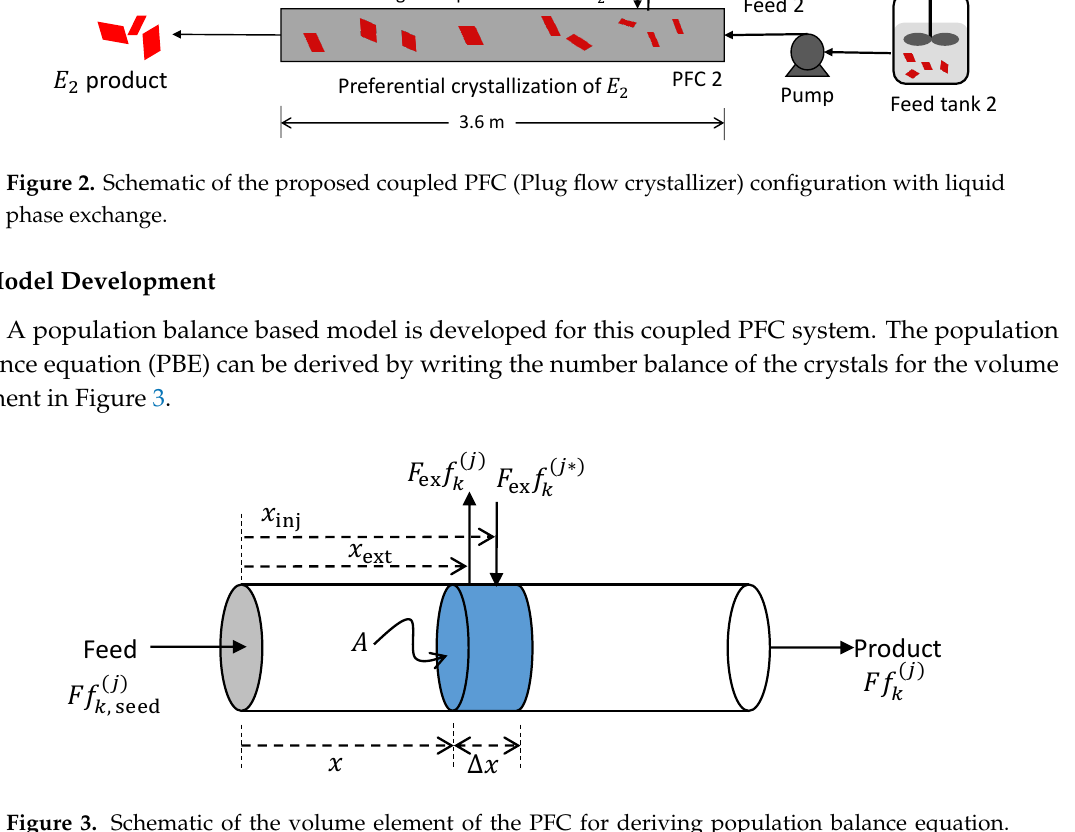
Figure 3. Schematic of the volume element of the PFC for deriving population balance equation. F denotes the volumetric flowrate of feed and product streams. Other symbols are defined after Equation